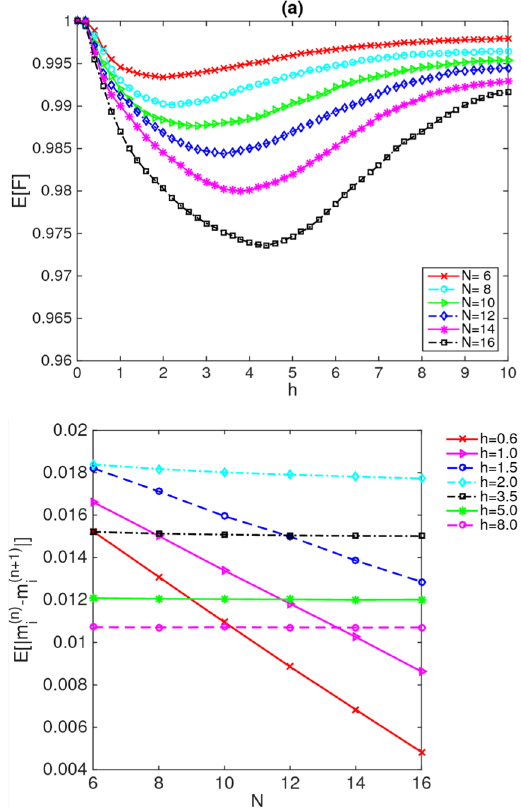
Figure 3. ( a ) Average fidelity as a function of the disorder strength h for system sizes from 6 to 16. The system sizes N are indicated in the legend. In the ergodic phase (at small h ), E[ F ] decays substantially under the dynamics until h approaches the critical point; then, in the localized phase (at large h ), E[ F ] increases again to approximately approach 1. ( b ) Average difference as a function of the system size N for different values of the disorder strength h . The values of h are indicated in the legend. In the ergodic phase (at small h ), where the eigenstates are thermal, these differences vanish exponentially in N as N increases, whereas they remain large in the localized phase (at large h